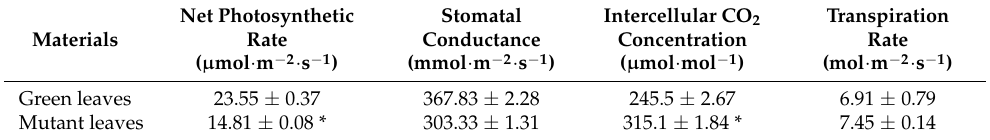
Table 1. Analysis of leaf gas-exchange in mutant and green leaves of the hybrid paper mulberry. Net Photosynthetic Materials Rate